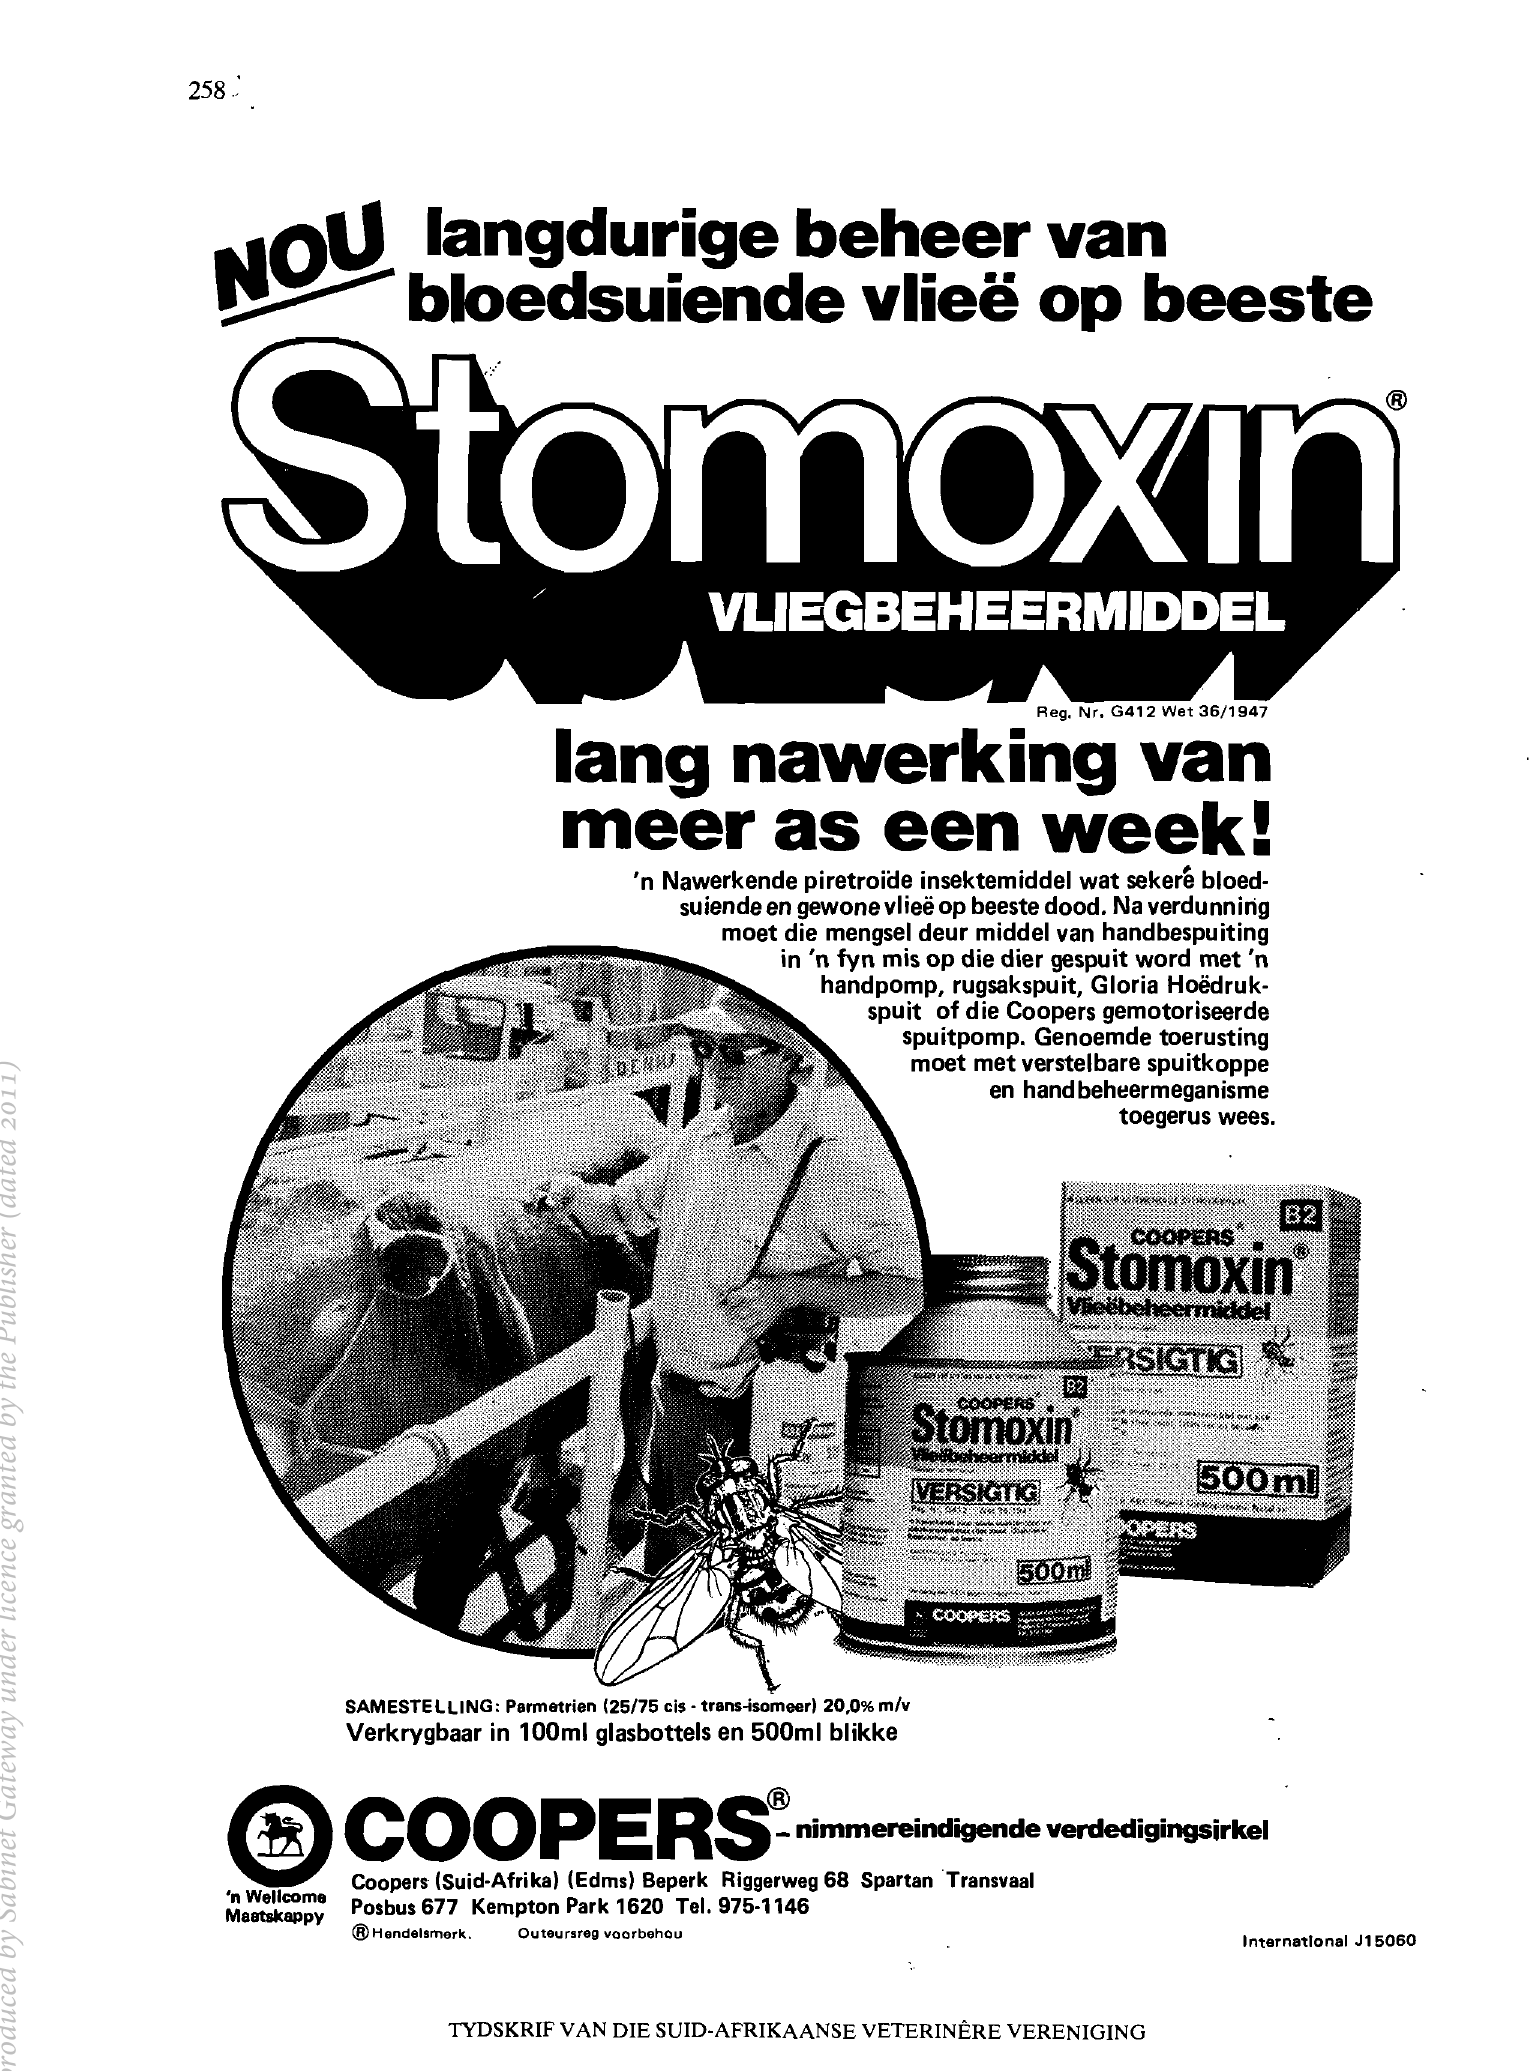
suiende en gewone vliee op beeste dood. Na verdunnirig moet die mengsel deur middel van handbespuiting in In fyn mis op die dier gespuit word met In handpomp, rugsakspuit, Gloria Hoedruk spuit of die Coopers gemotoriseerde spuitpomp. Genoemde toerusting moet met verstelbare spuitkoppe en hand beh~ermeganisme toegerus